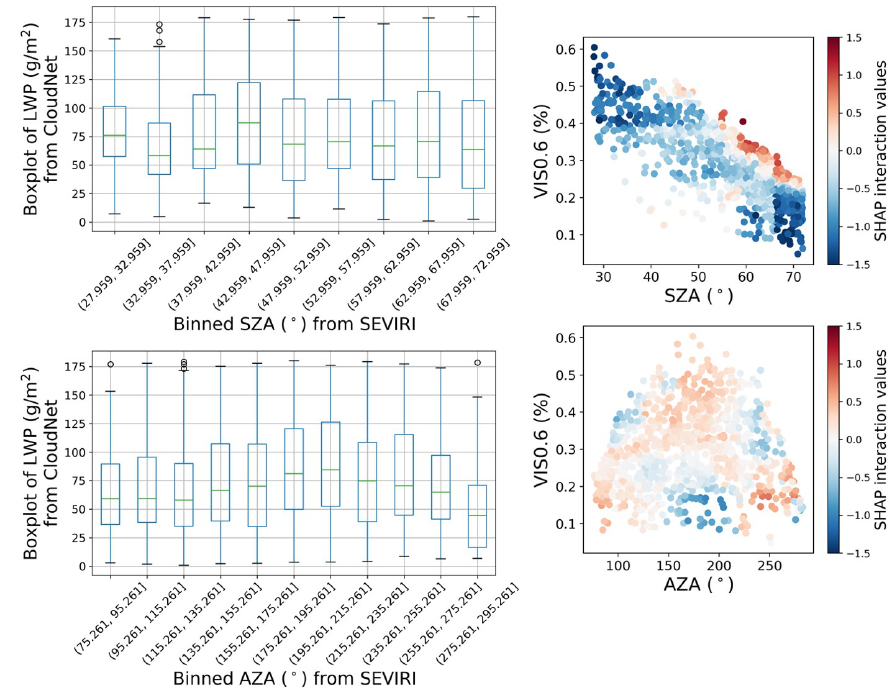
Figure 9. Box plot ( left ) of LWP based on SZA and AZA and SHAP interaction values ( right ) for between LWP and the satellite viewing geometry in